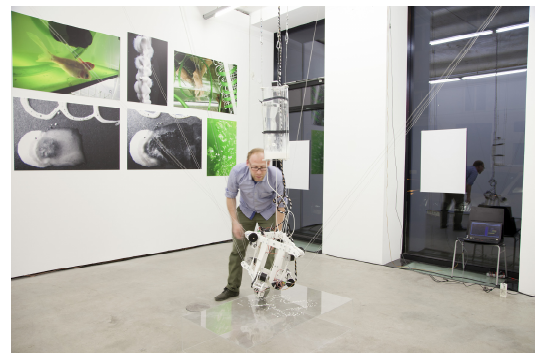
Figure 19. Star cable printer installed in the exhibition space. © Bruno Stubenrauch.